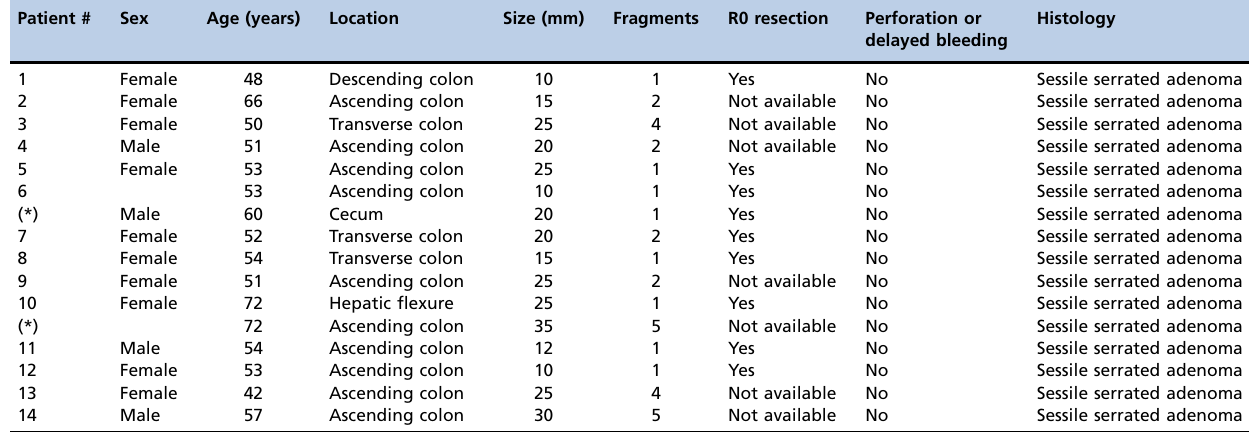
Table 1 - Patient and treatment